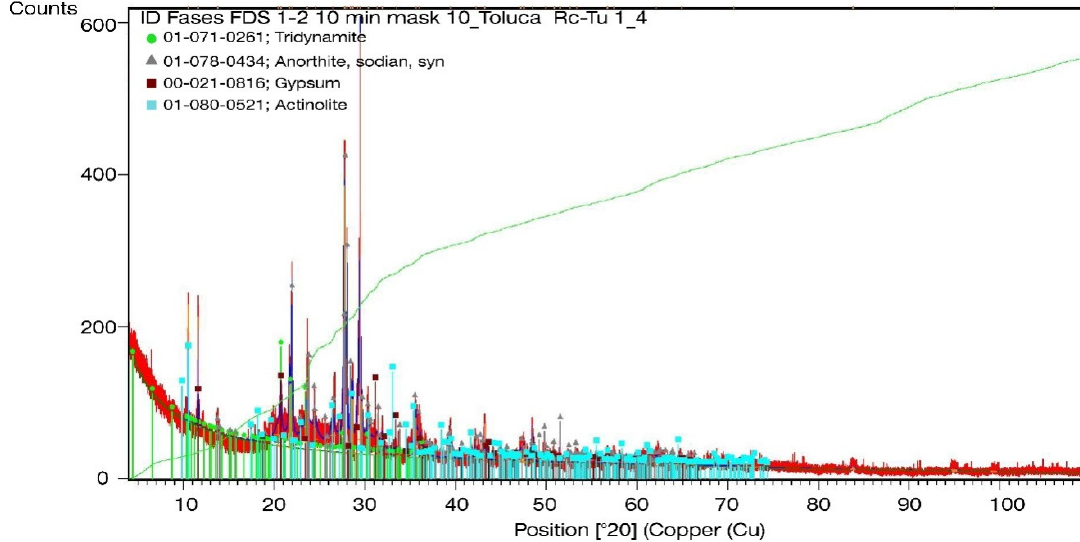
Figure 7. Diffractogram of the construction waste 6.3 mm fines all in one.